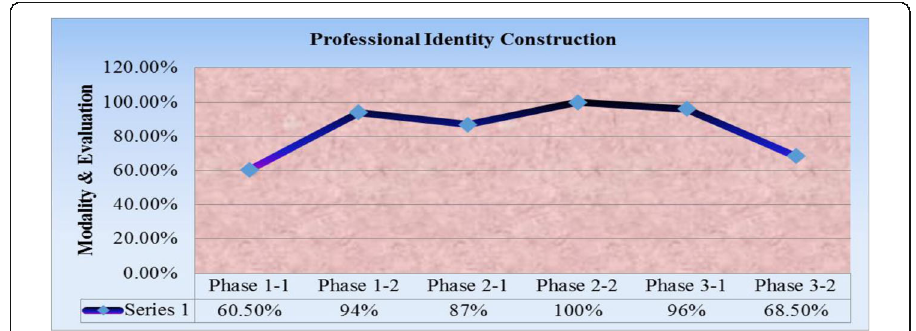
Fig. 4 Professional Identity Construction of EFL Pre-service Teachers across the ESA